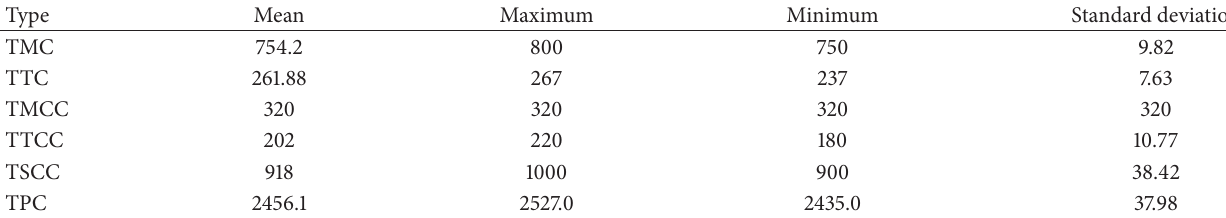
Table 11: Average results of simulation experiment.